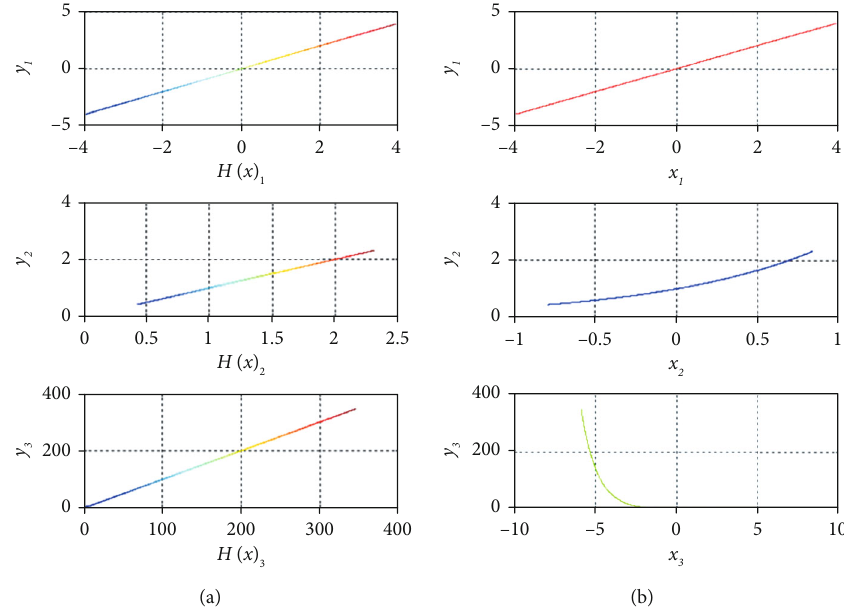
Figure 16: The synchronization relationships of di ff erent state variables in the unidirectionally coupled Chua ’ s circuit. (a) H ð x Þ = Þ T and y = ð y ð H ð x Þ , H ð x Þ , H ð x Þ 1 2 3 synchronization with respect to the exponential manifold y = ½ x